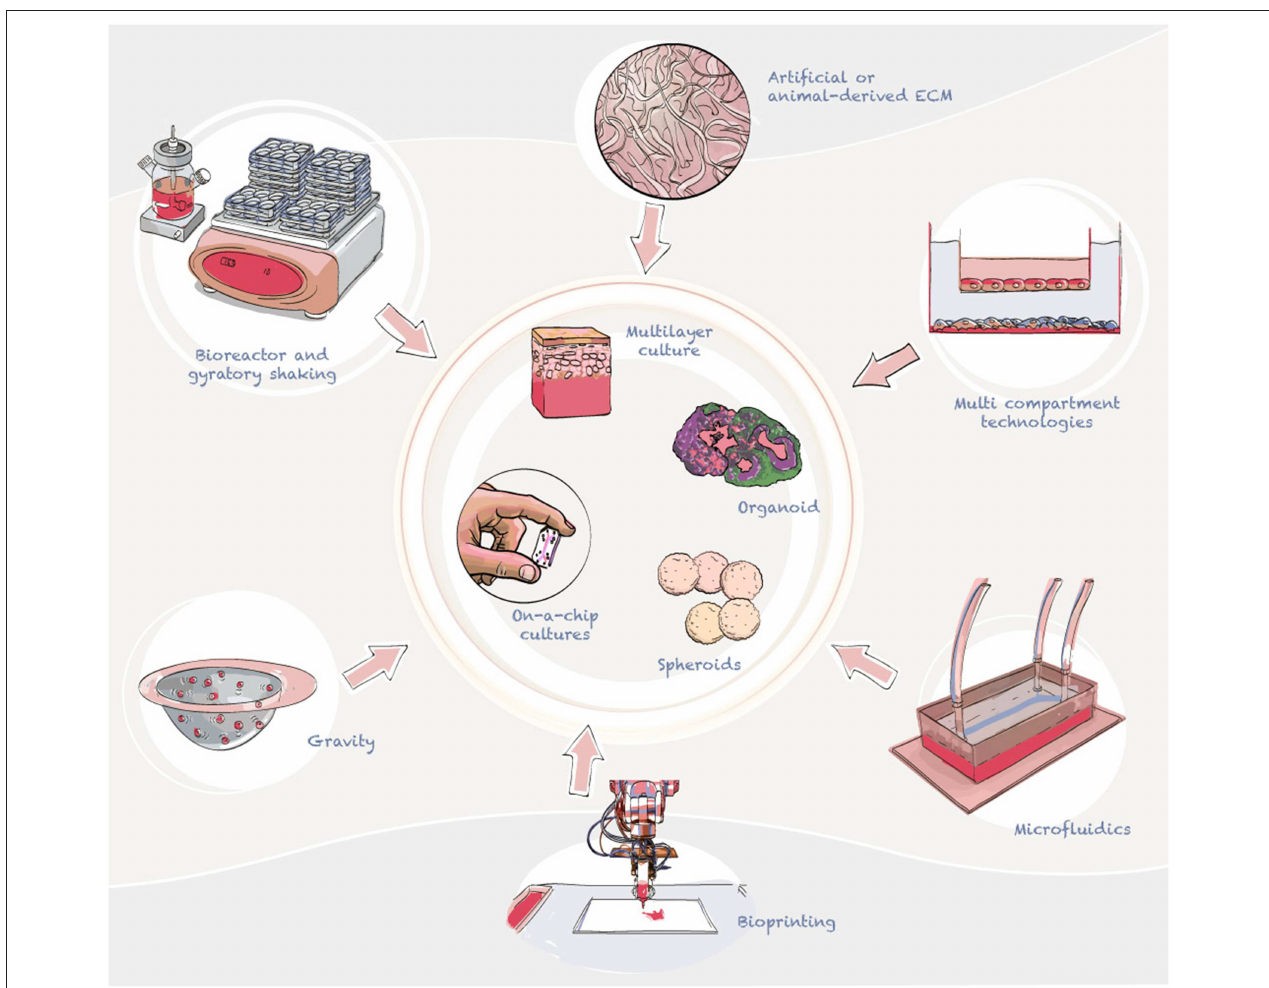
FIGURE 3 | Advanced cell culture technologies currently employed to develop in vitro models of the brain and blood-brain barrier. In the diagram we summarize the main ways to generate 3D cultures, aggregating and multilayer technologies. Aggregation can be used to generate 3D cultures, for this gravity or shaking are used to form cell structures (normally spheric). Cells can also be plated to produce layers of different cell types to model tissues such as